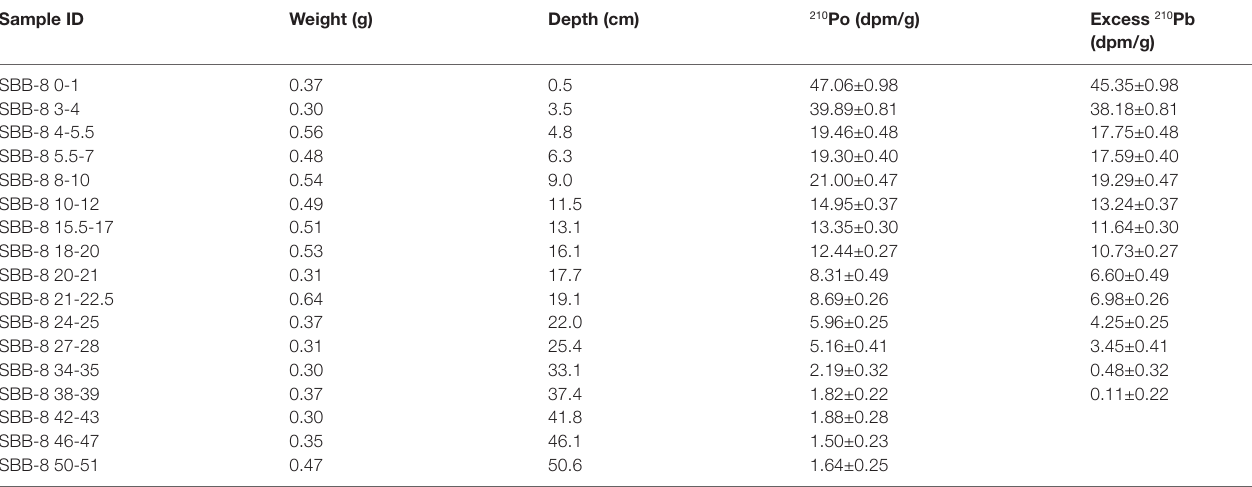
TABLE 1 | 210 Pb dating results. The excess 210 Pb is determined by the 210 Po at each layer subtracting the mean 210 Po value averaged from the four 210 Po values in the deep part. Sample